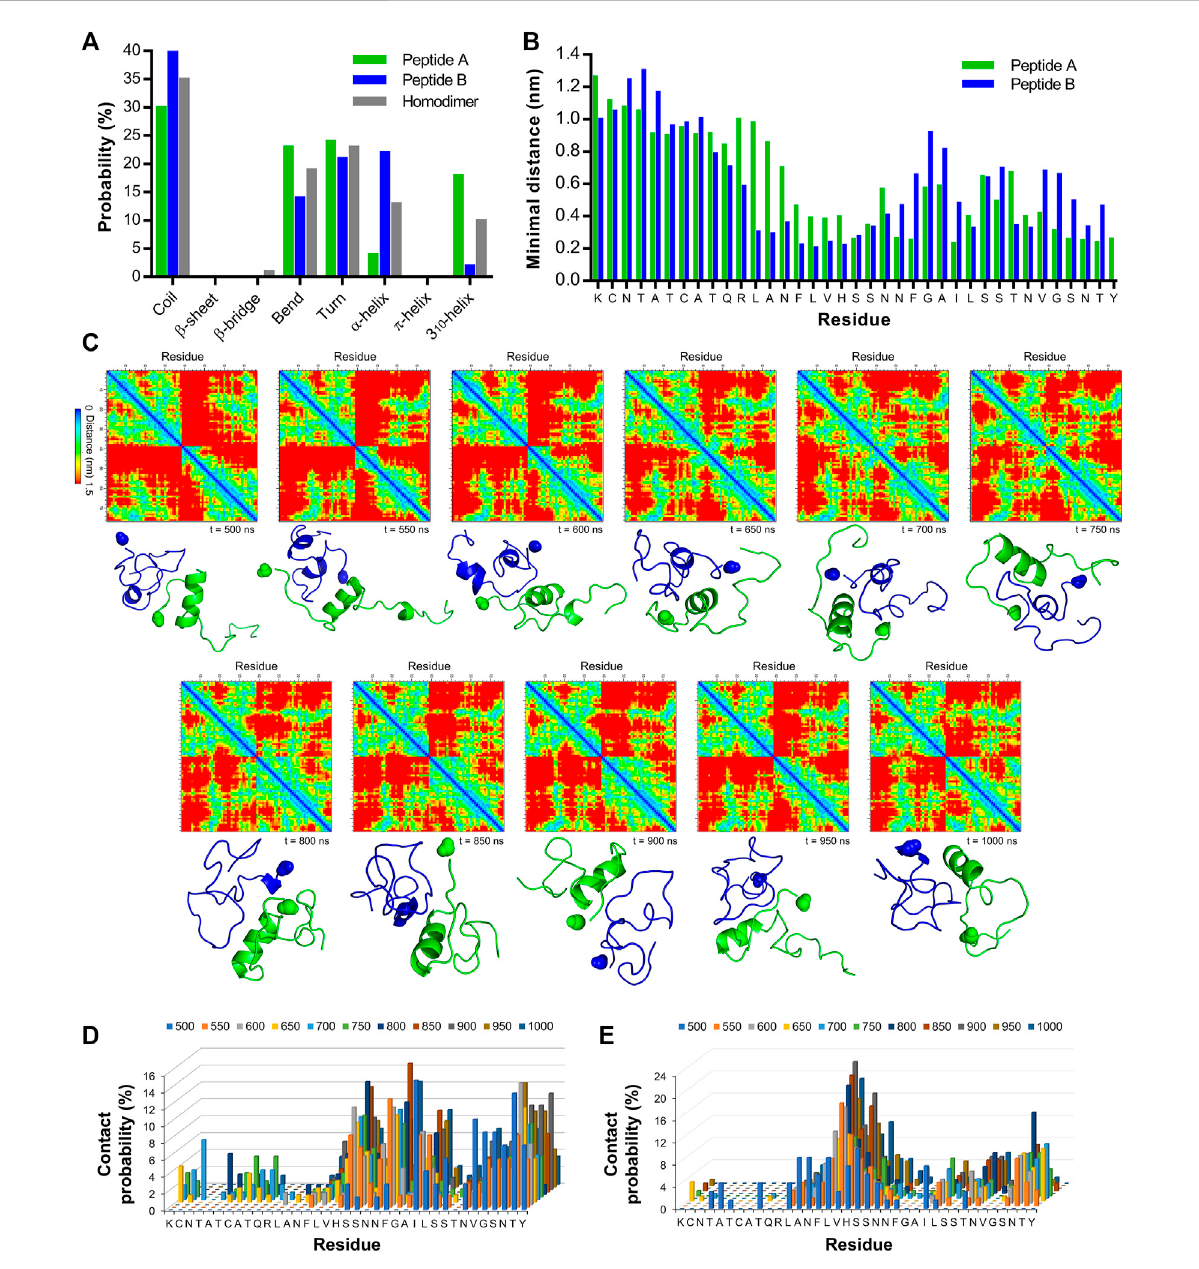
FIGURE 2 All-atom molecular dynamics simulation of IAPP self-recognition (A) Average secondary structure probability in IAPP homodimer and discrete monomers. (B) Average minimal distances for each residue of peptide A with the entire peptide B as well as for each residue of peptide B with the entire peptide (A) (C) Interchain pairwise (residue-residue) distance maps for IAPP homodimer and corresponding cartoon representation of IAPP dimer at every 50 ns over the 500 – 1,000 ns interval. The C-terminal amide group is highlighted as a sphere. Peptide A is represented in green and peptide B in blue (D,E) Probability of interchain pairwise (residue-residue) contacts ( < 0.6 nm distance) for every 50 ns over the 500 – 1,000 ns interval for (D) peptide A and (E) peptide (B)